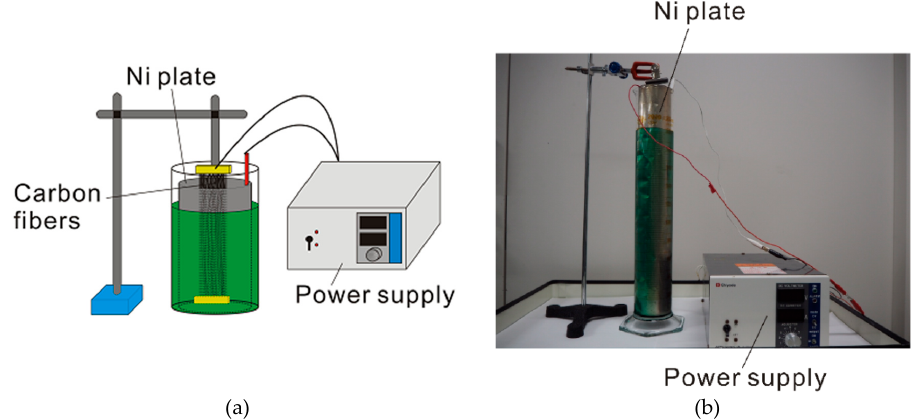
Figure 1 . Schematic drawing and photo image of Ni electrolytic plating method. ( a ) Schematic drawing. ( b ) Photo image.